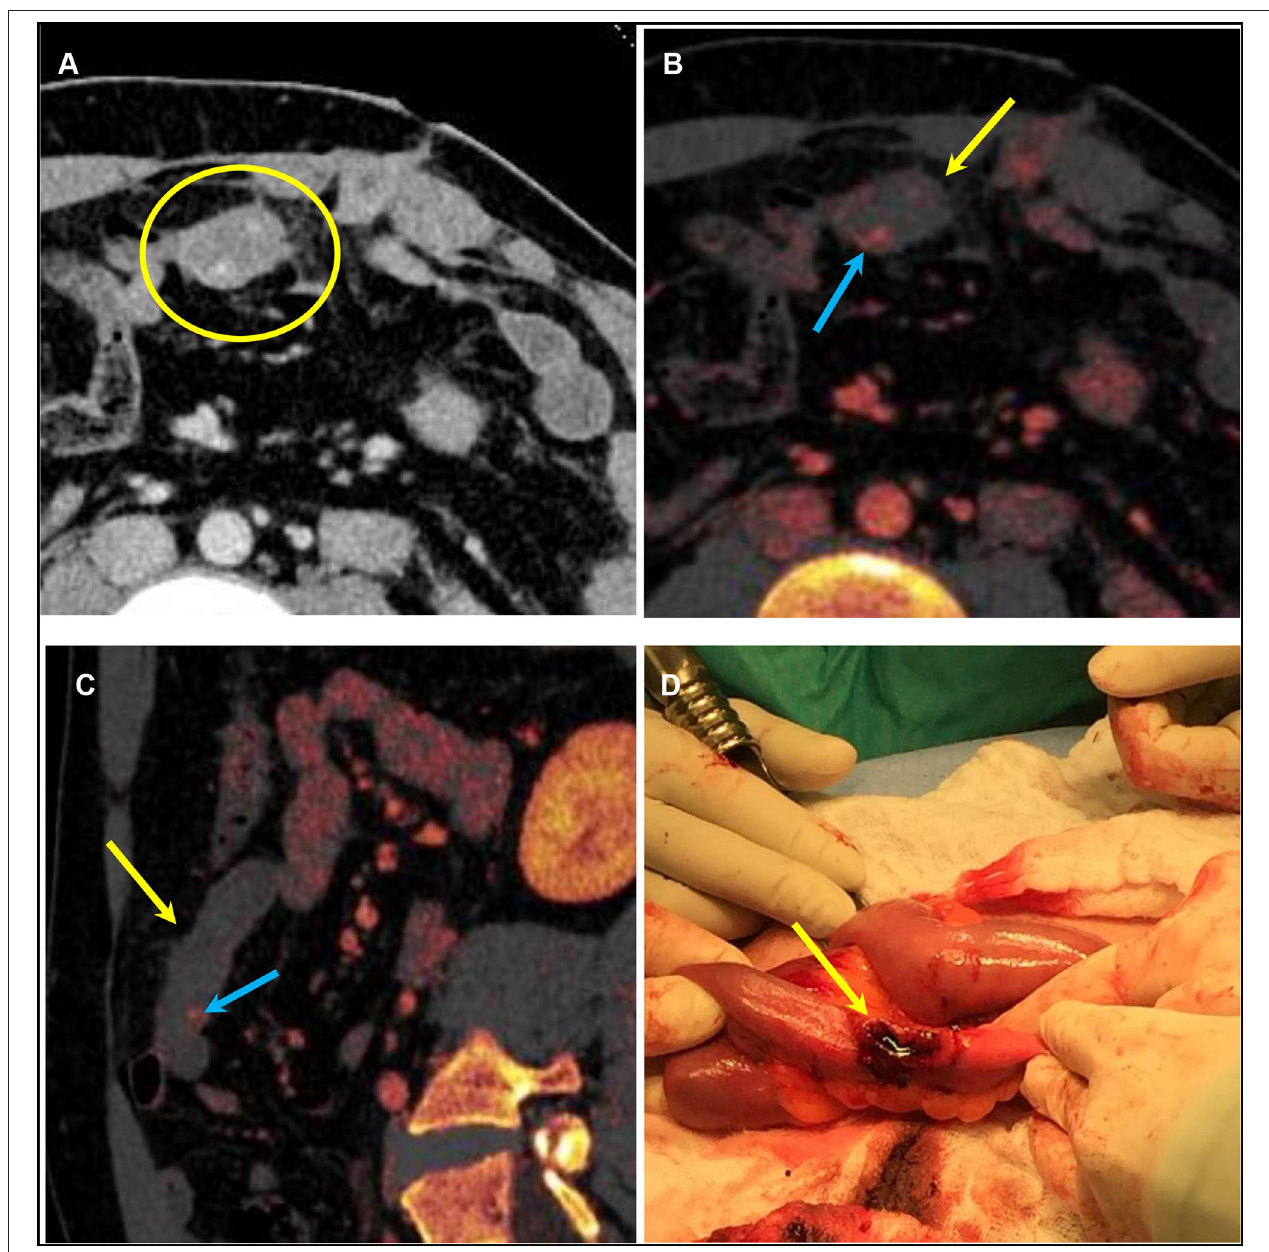
FIGURE 3 | A 25-year-old male patient with a stab wound to the anterior abdomen. (A) Conventional mixed DECT image demonstrates mild thickening of a small bowel loop (yellow arrow). [ (B) Axial and (C) ] Sagittal oblique DECT iodine overlay images demonstrating an area of transmural lack of iodine uptake anteriorly (yellow arrows) and a small area of endoluminal contrast extravasation not seen on the conventional image (blue arrows) concerning a penetrating injury. (D) Intraoperative picture confirming the focal transmural small bowel perforation (yellow arrow). DECT, dual-energy